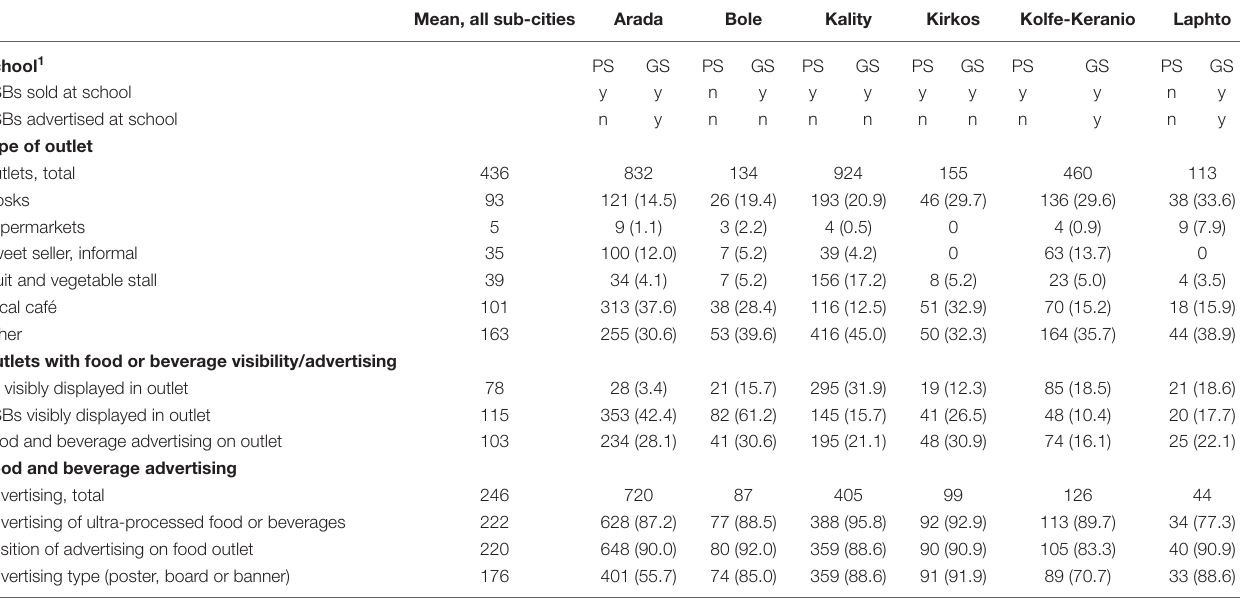
TABLE 4 | Food outlets (type, characteristics) and advertising in and around (0.5km radius) schools (private and government) in the respective sub-city of Addis Ababa, Ethiopia, n (%). Mean, all sub-cities Arada